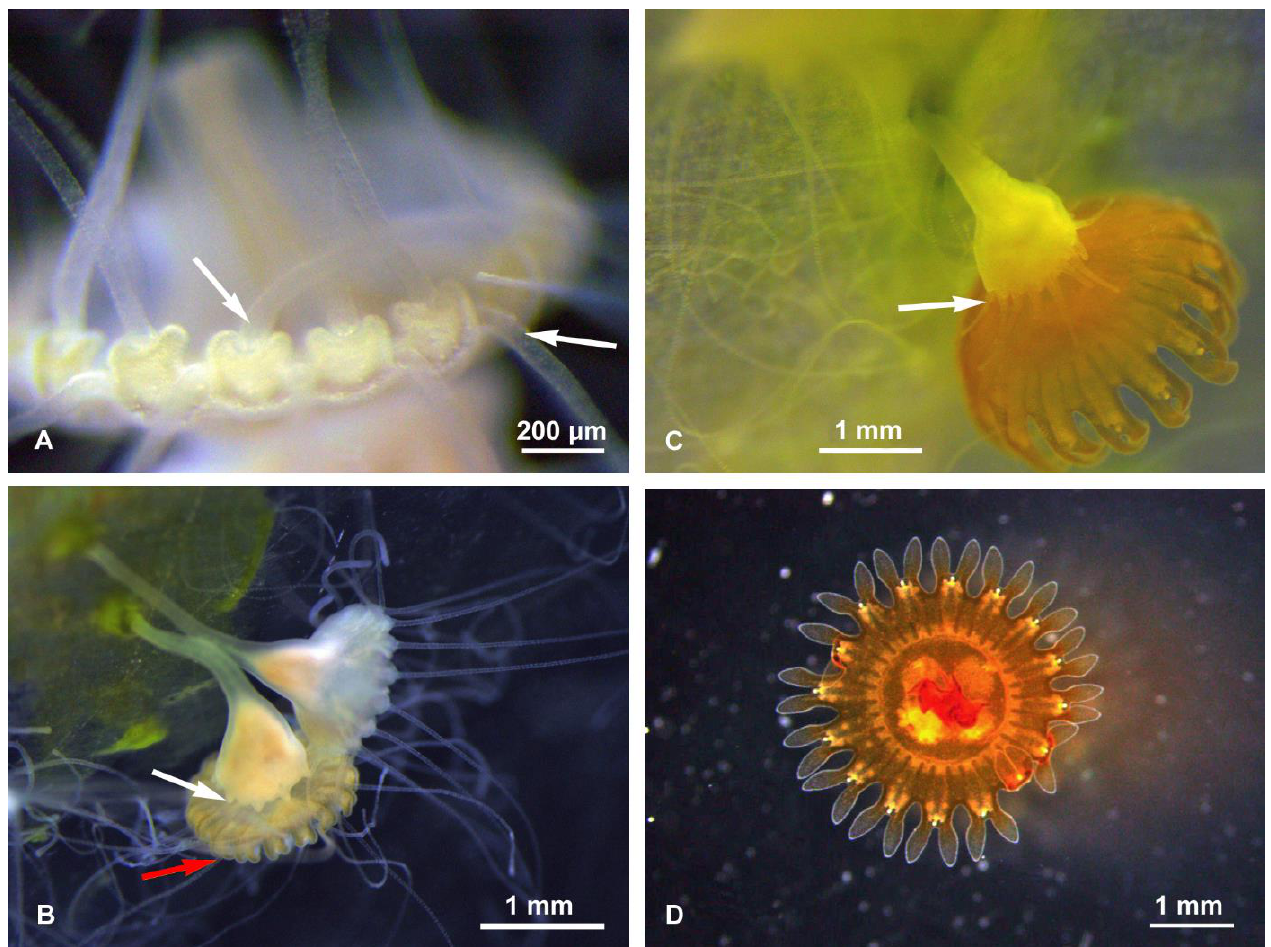
Figure 2. Sanderia malayensis , strobilation and ephyra. ( A ) Detail of the oral disc margin, with the marginal lappets of the future ephyra in formation, and polyp tentacles still present (arrows). ( B ) Two scyphistoma in different strobilation stages, early (top) and more advanced (bottom), where the polyp is regenerating its tentacles (white arrow) even before those present on the edge of the ephyra are totally reabsorbed (red arrow). ( C ) Strobilation in final phase, polyp with new tentacles (arrow), and ephyra close to detachment and already colored. ( D ) Just released ephyra, sub-umbrellar view.